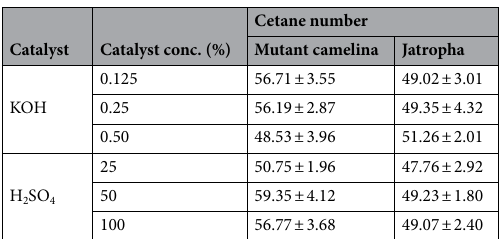
Table 9. Cetane numbers of biodiesel from mutant camelina and jatropha seed biodiesel.